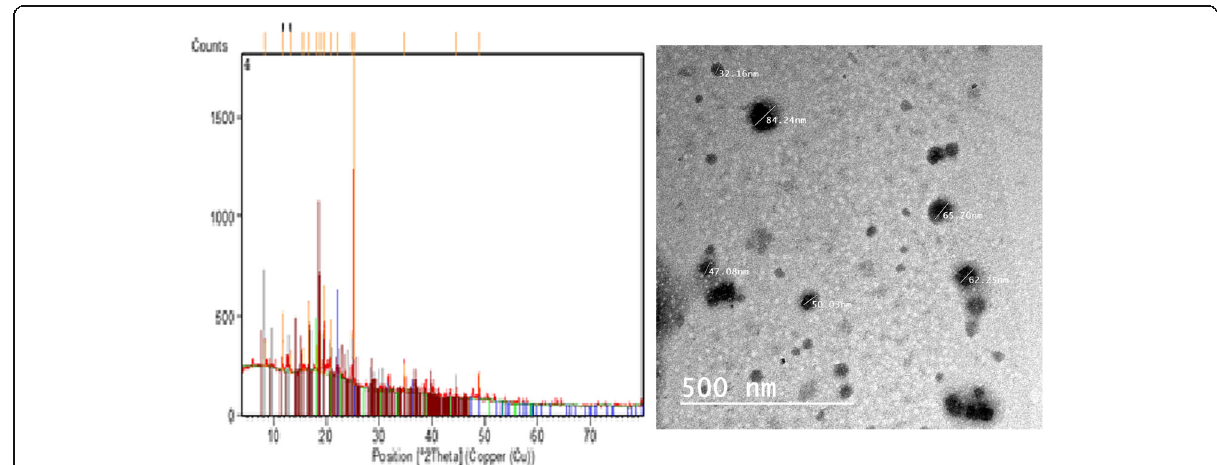
Fig. 1 Transmission electron microscopy (TEM) image of nano-chocolate fortified with